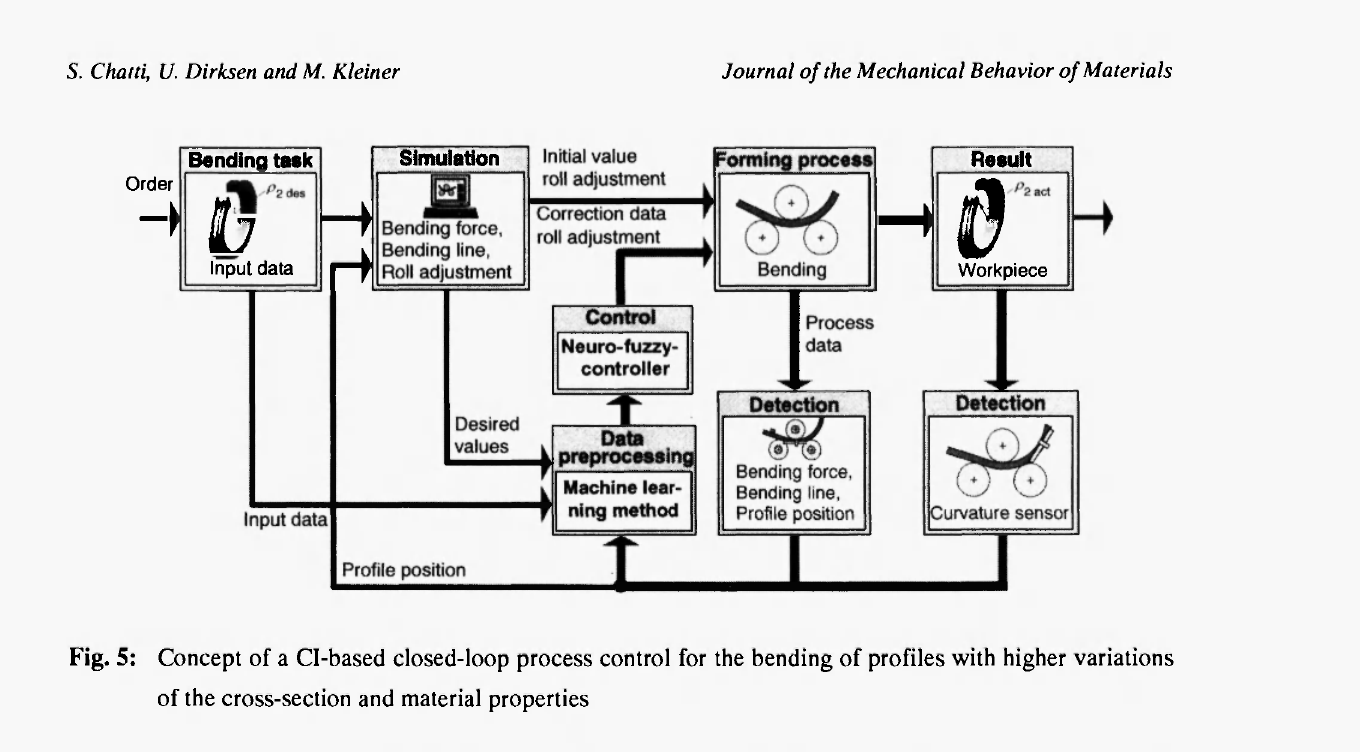
Fig. 5: Concept of a CI-based closed-loop process control for the bending of profiles with higher variations of the cross-section and material